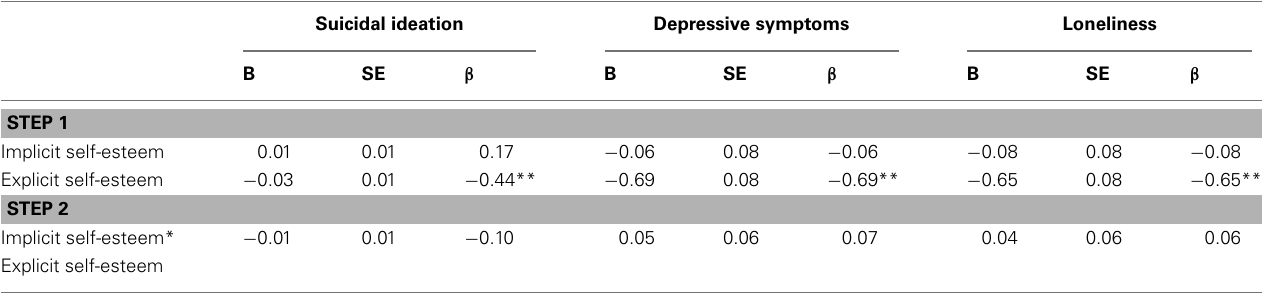
Table 3 | Hierarchical multiple regression analyses: associations of explicit self-esteem, implicit self-esteem, and the Interaction between implicit and explicit self-esteem with suicidal ideation, depressive symptoms, and loneliness.